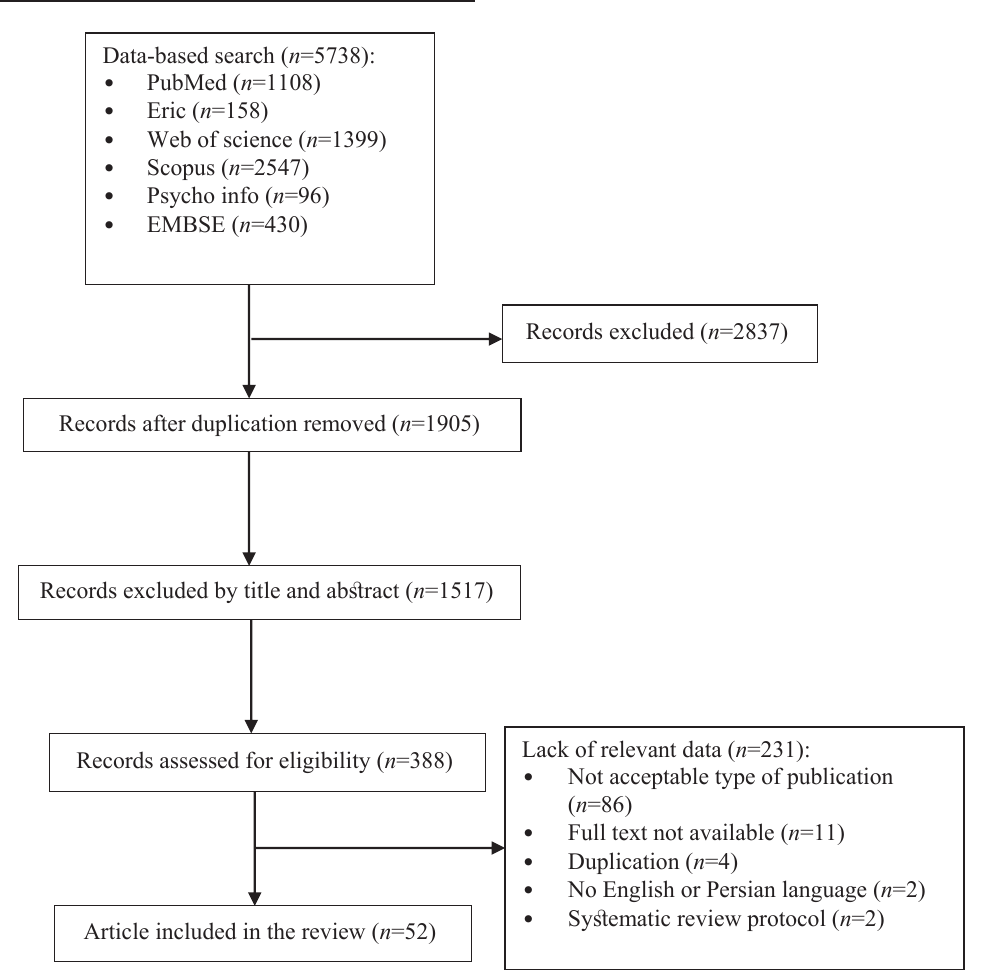
Figure 1. PRISMA diagram. PRISMA, Preferred Reporting Items for Systematic Reviews and